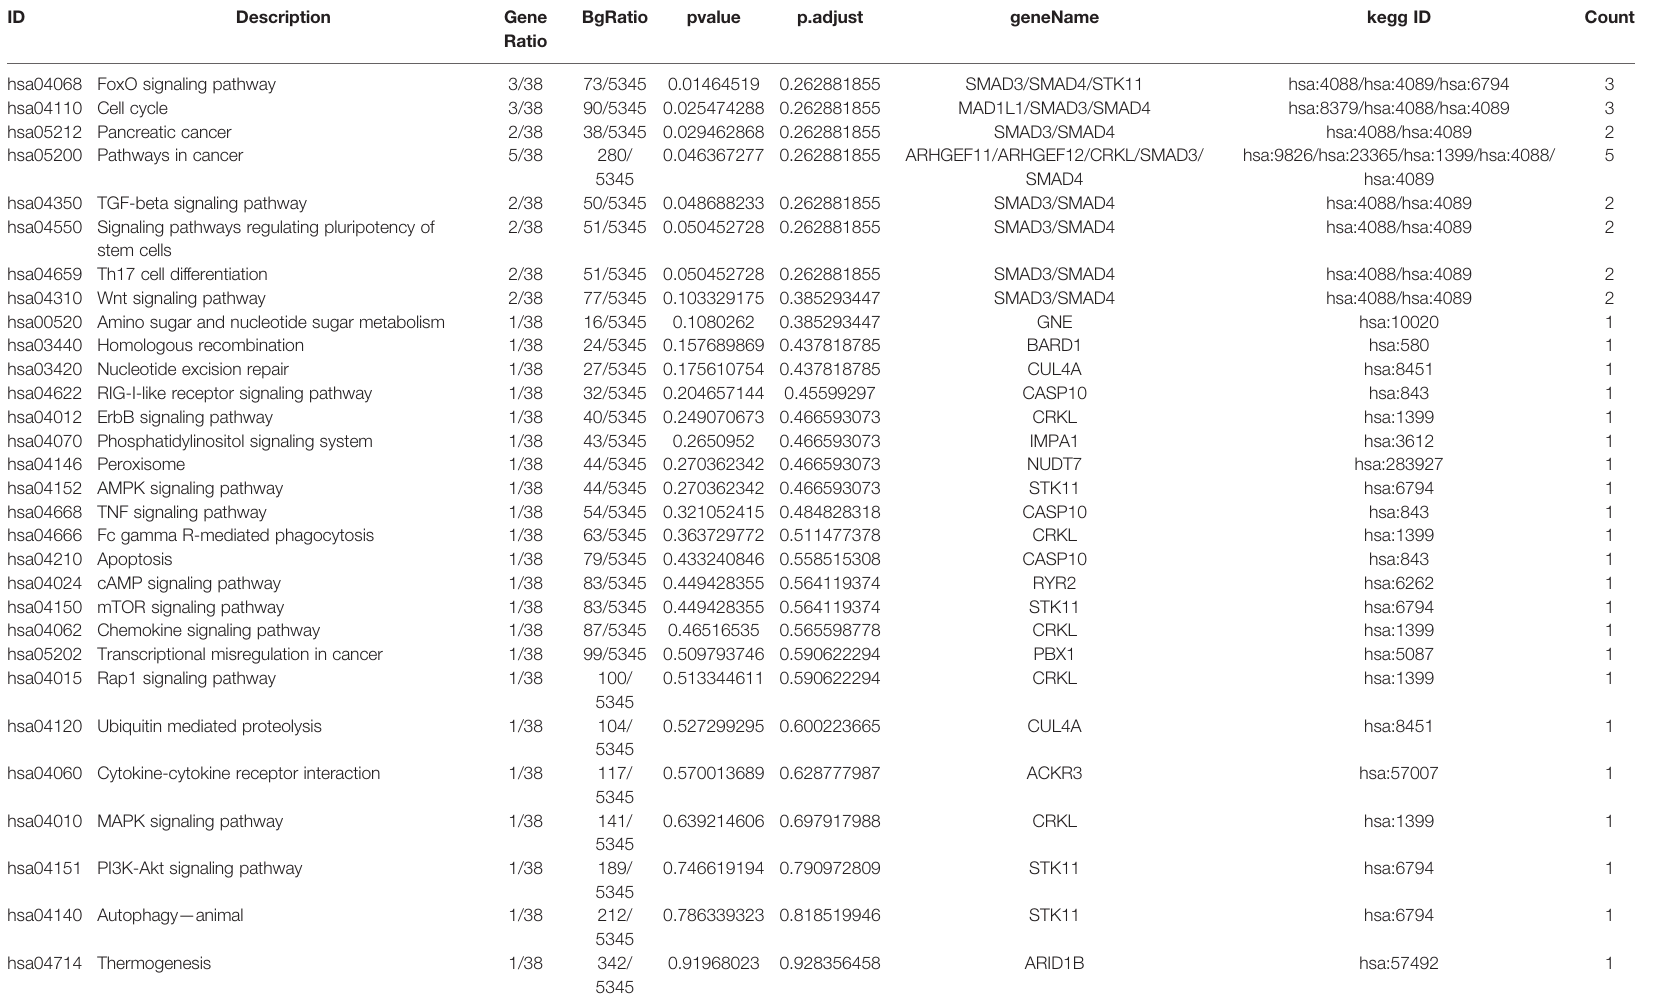
TABLE 3 | RI Related Pathways of Somatic Mutation Related